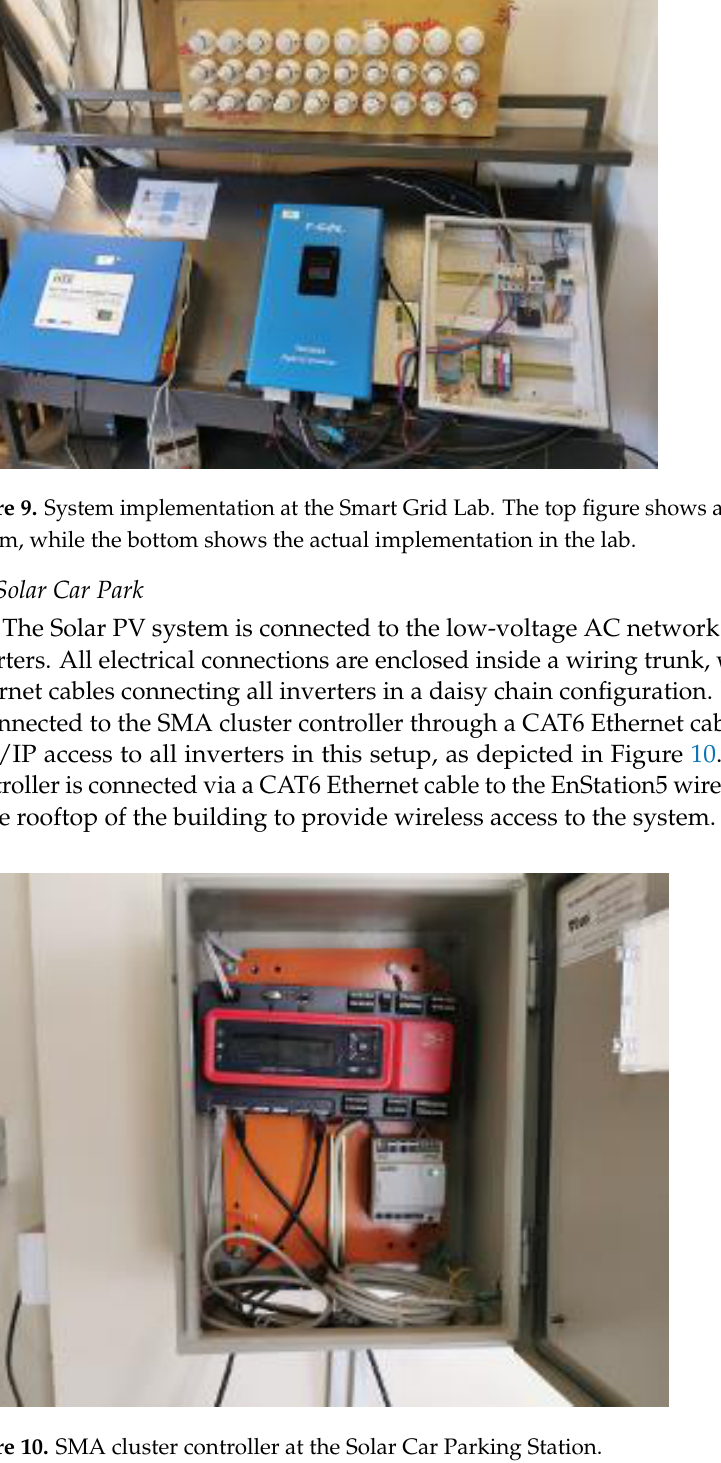
Figure 10. SMA cluster controller at the Solar Car Parking Station.